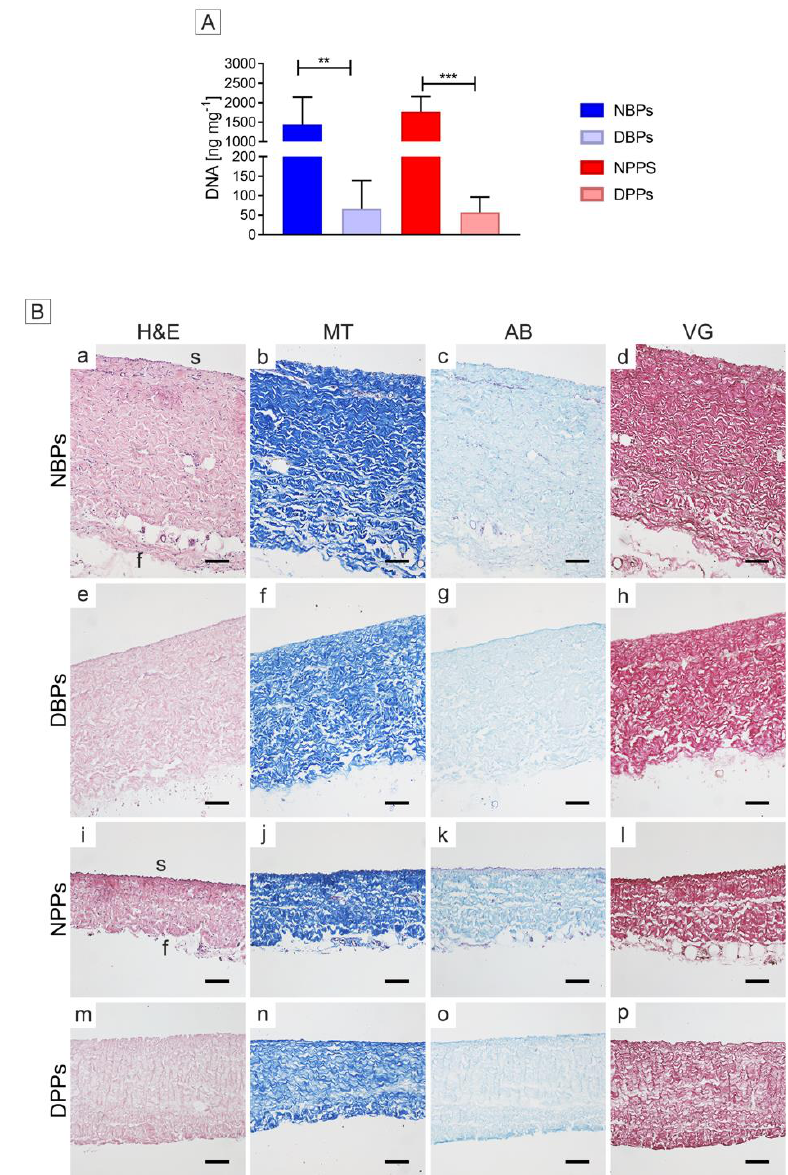
Figure 1. Decellularization yield of bovine and porcine pericardia after TRICOL procedure. ( A ) DNA content before and after decellularization. The data are presented as mean ± standard deviation (SD). DNA was significantly reduced in decellularized scaffolds when compared to native ones. ** p < 0.01; *** p < 0.001. ( B ) Histological evaluation before and after decellularization. Intact extracellular matrix (ECM) and no nuclear material were revealed in decellularized bovine (e) and porcine (m) pericardia with respect to their native counterparts (a and i) (Haematoxylin and eosin (H&E)). Collagen organization was intact after decellularization (f for bovine and n for porcine), as in the native corresponding samples (b and j) (Masson trichrome (MT)). A light discoloration was observed for Alcian blue (AB) in decellularized bovine (g) and porcine (o) pericardia with respect to their native counterparts (c and k). No changes in the elastic fibers were detected between the bovine and porcine ECM of native (d and l, respectively) and decellularized (h and p, respectively) pericardia (Van Gieson (VG)). Magnification bars: 100 µm. s= serosa , f= fibrosa . NBP = Native Bovine Pericardium, DBP = Decellularized Bovine Pericardium, NPP = Native Porcine Pericardium, and DPP = Decellularized Porcine Pericardium.